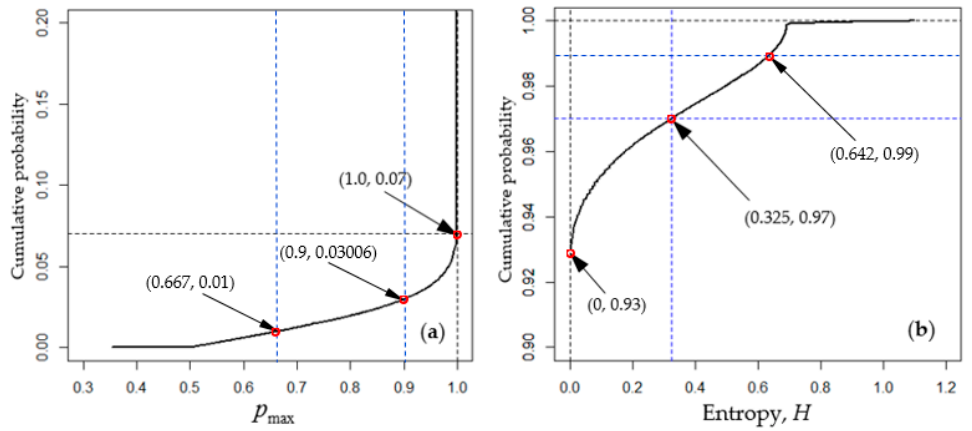
Figure 10. Empirical cumulative distribution functions of: ( a ) the maximum class probability ( max p ); and ( b ) the Shannon entropy ( H ).